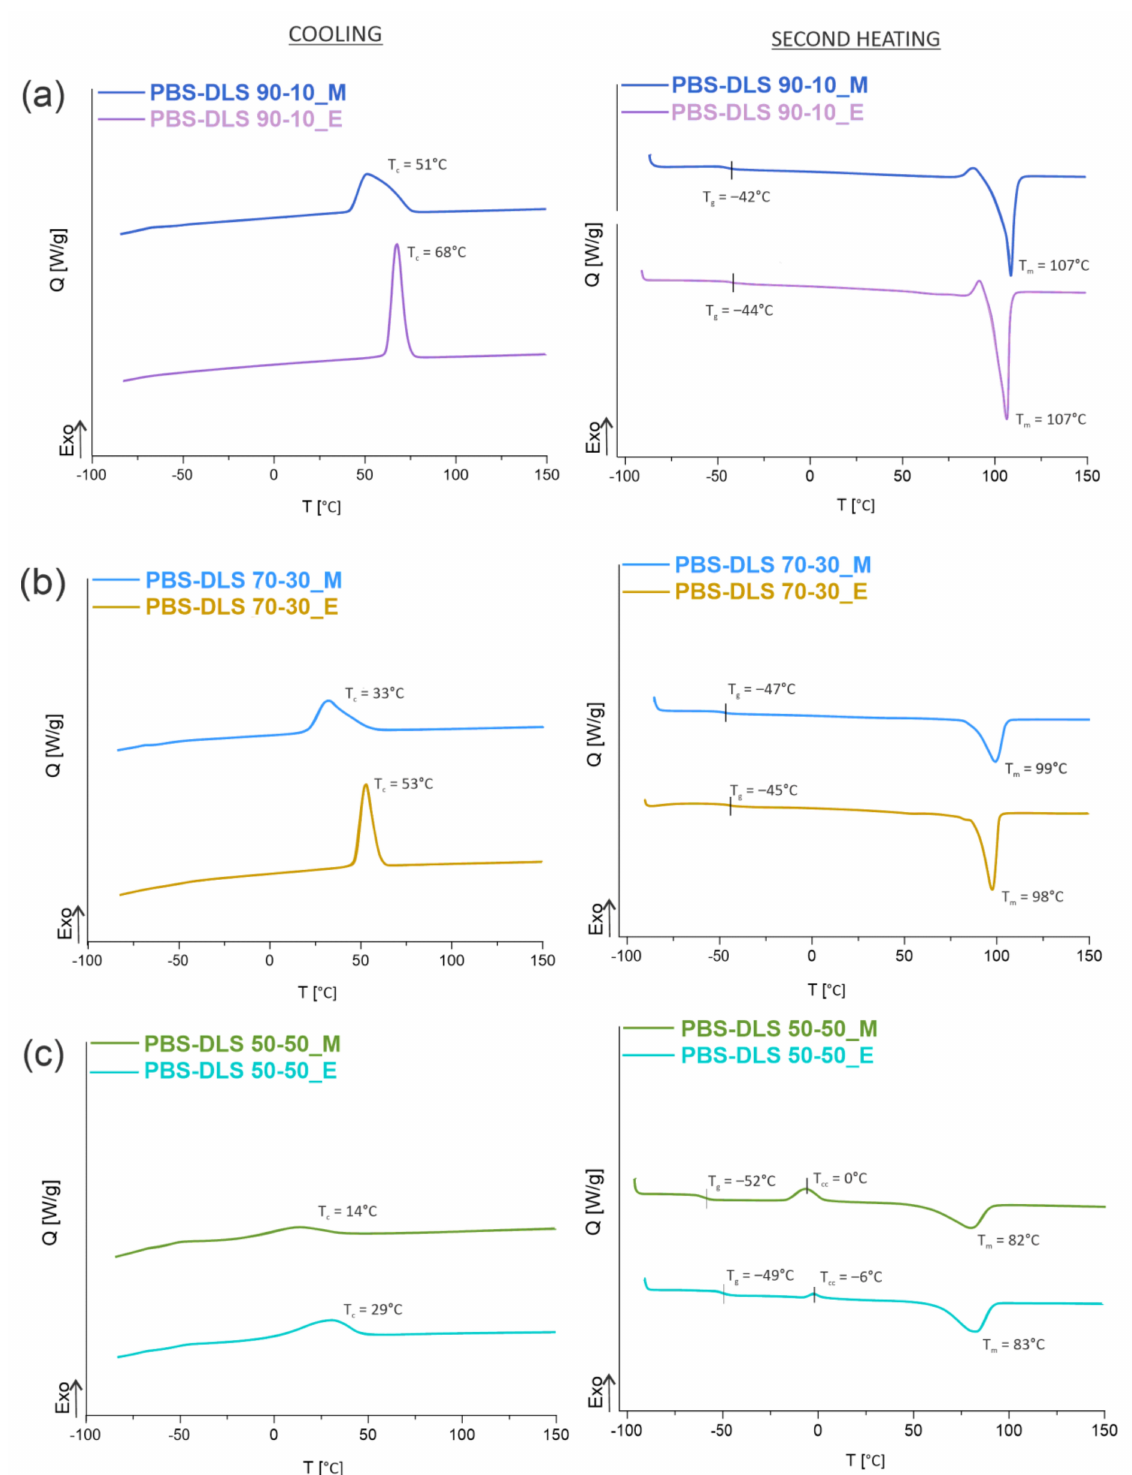
Figure 6. DSC cooling and second heating thermograms of PBS-DLS_E and PBS-DLS_M series